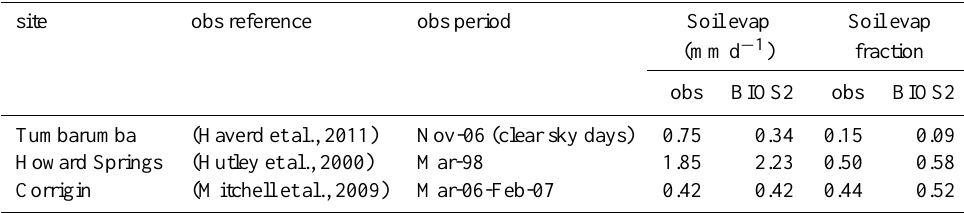
Table 4. Observed soil evaporation flux: total and as a fraction of ET at 3 field sites, and corresponding BIOS2 estimates.